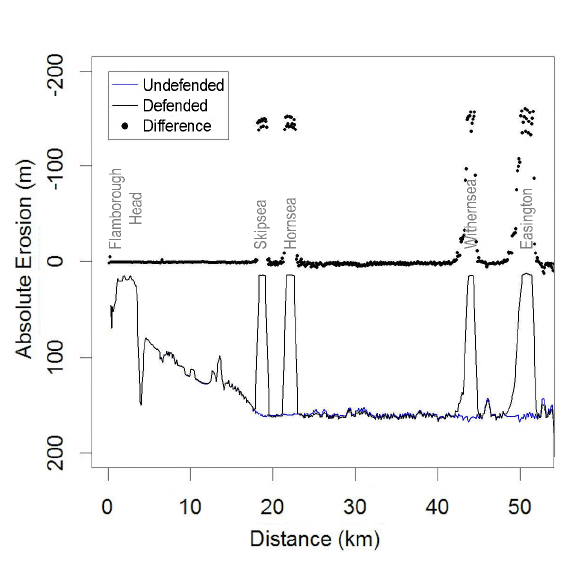
Figure 2. Absolute erosion after 90 years of simulation for the un- defended (blue line) and defended (black line) coastlines under the baseline wave climate (2009–2010 repeated cycle). The di ff erence between these scenarios is highlighted by the black points. Flambor- ough Head and the towns with sea wall defences that are included in the model are labelled in grey text at their respective location on the coastline.